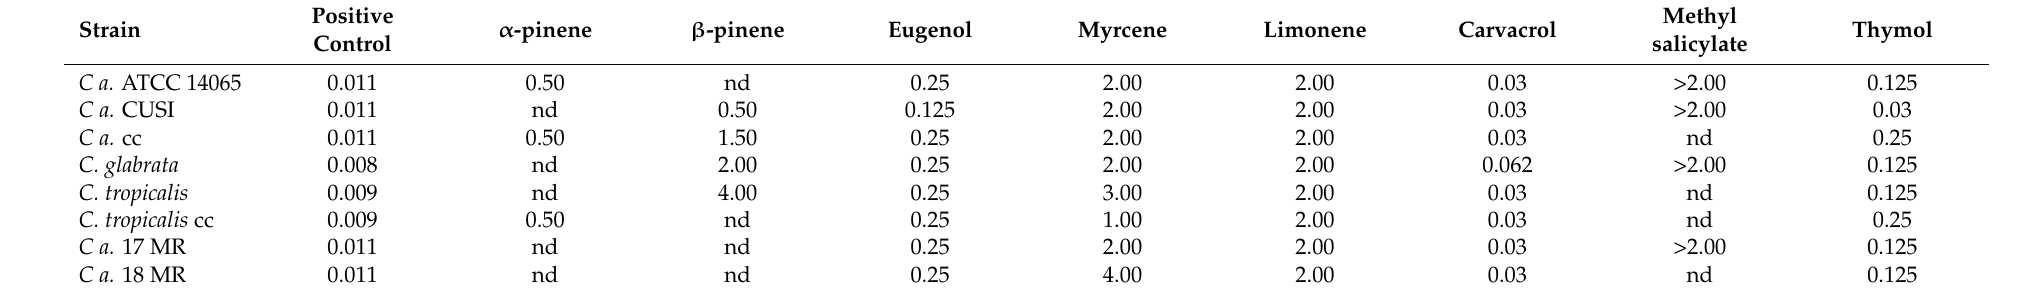
Table 6. Minimal inhibitory concentrations of some compounds in yeast